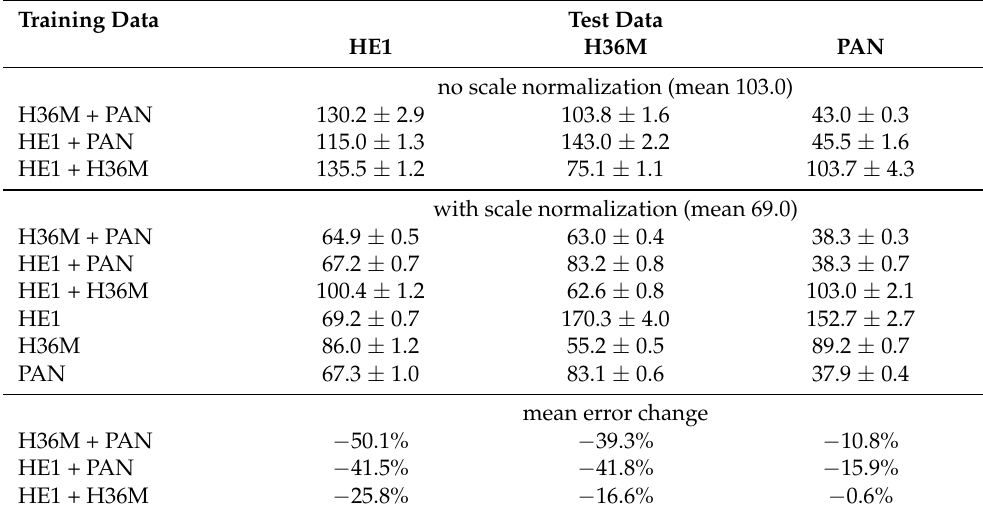
Table 11. Error of multi-database training with and without scale normalization (no-alignment errors in mm, mean ± std.